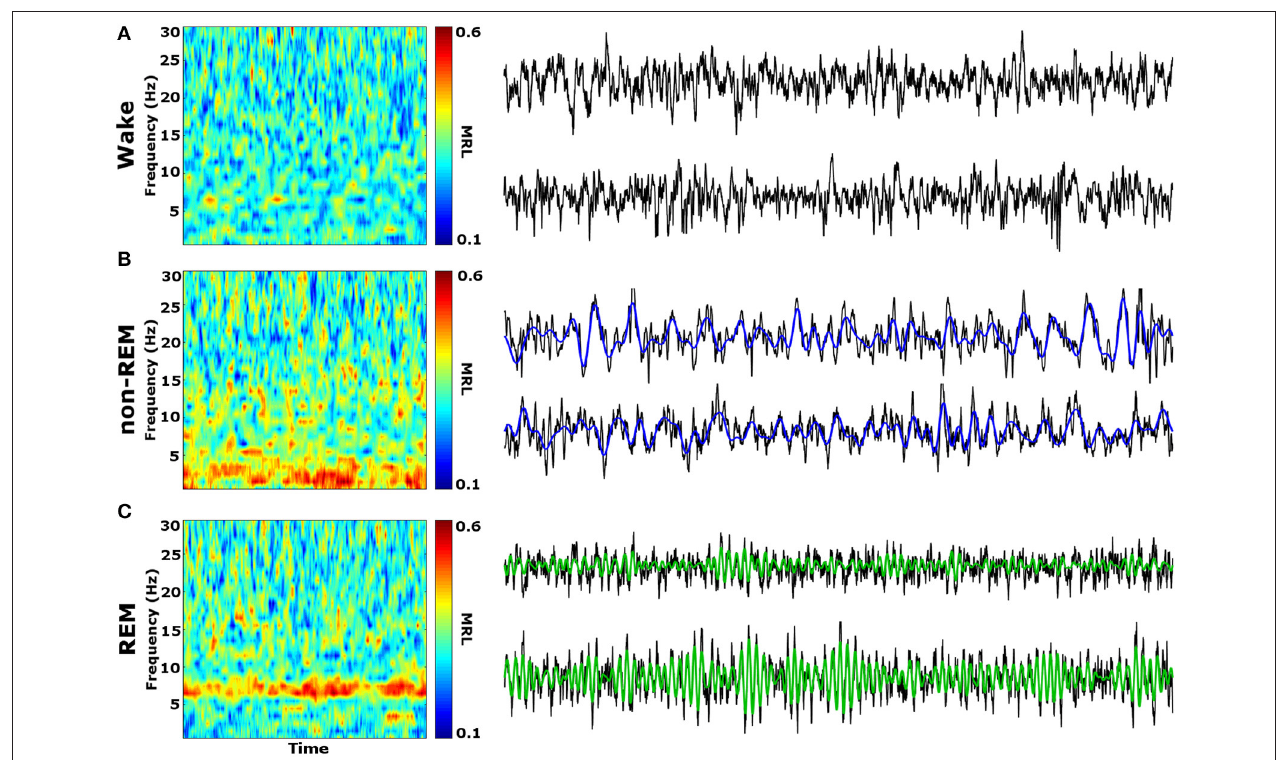
FIGURE 3 | Qualitative Spectrograms of Oscillatory Synchrony across Vigilance States. Example spectrograms displaying typical synchrony (MRL) during vigilance states and their respective LFPs. Although phase-locking was seldom observed during wakefulness (A) , delta oscillation (blue filtered LFP) phase-locking was found to be prominent during non-REM sleep (B) , and theta oscillation (green filtered LFP) phase-locking was prominent during REM sleep (C) . LFPs represent 10 averaged epochs from one animal. MRL, mean resultant length; LFPs, local field